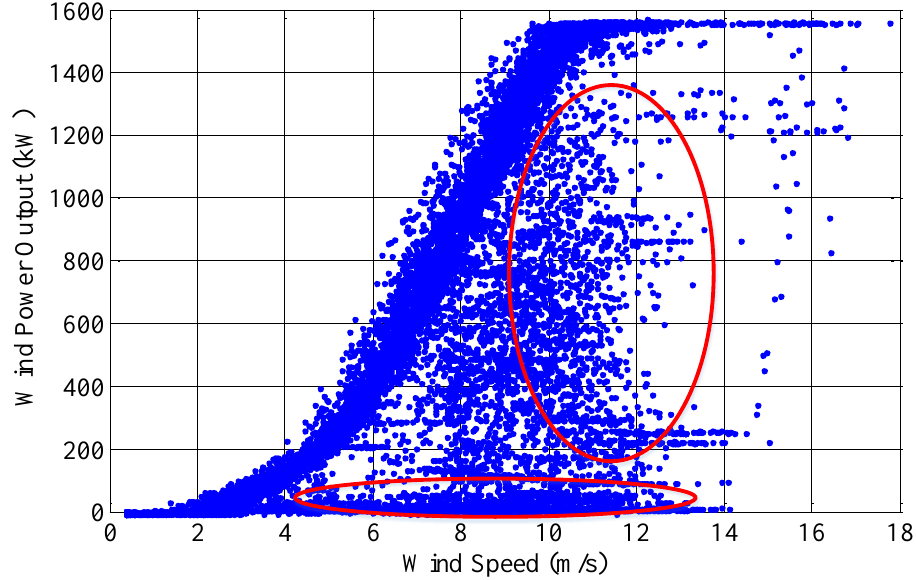
Figure 2. The scatter plot of a wind turbine.